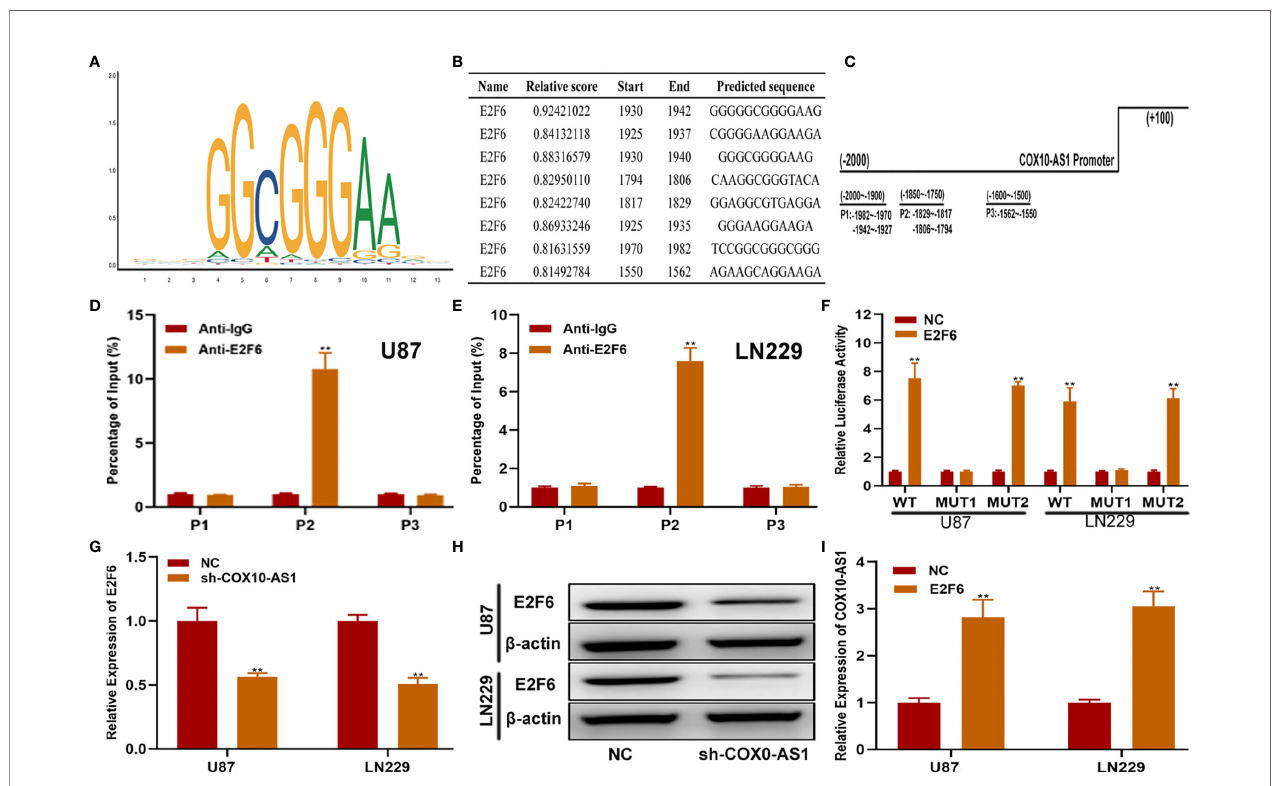
FIGURE 9 | E2F6 regulates COX10-AS1 expression by binding to its promoter region. (A) The binding motif of E2F6 determined from JASPAR. (B, C) The top fi ve binding sites in the COX10-AS1promoter and their corresponding three counterparts in the promoter region are shown. (D, E) ChIP assays were performed to reveal the af fi nity of E2F6 to the COX10-AS1 promoter in U87 and LN229 cells. (F) Luciferase reporter assays were used to locate the binding sequences of E2F6 to the COX10-AS1 promoter. (G, H) The expression level of E2F6 in glioma cell lines transfected with sh-COX10-AS1 or sh-NC, as measured by qRT-PCR and western blot. (I) The expression level of COX10-AS1 in glioma cell lines transfected with E2F6 plasmid or NC, as measured by qRT-PCR. **P <